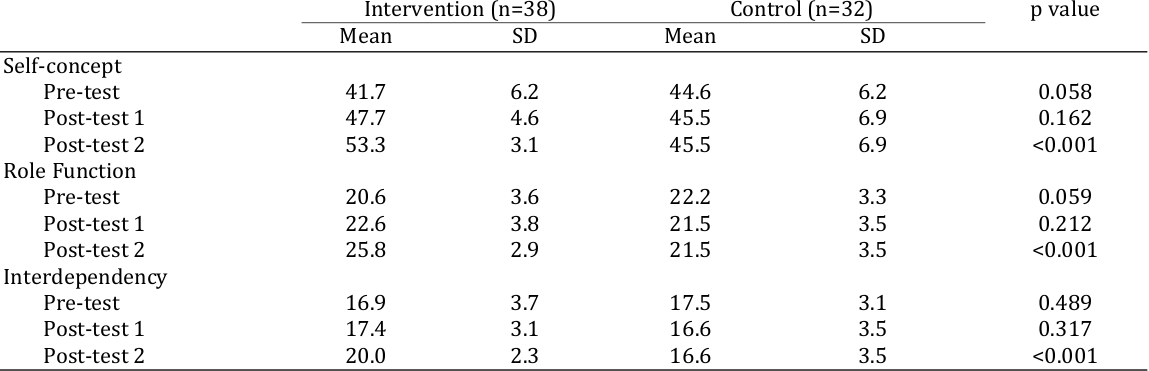
Table 3. The effectiveness of Roy’s adaptation behaviour for patients with chronic kidney disease